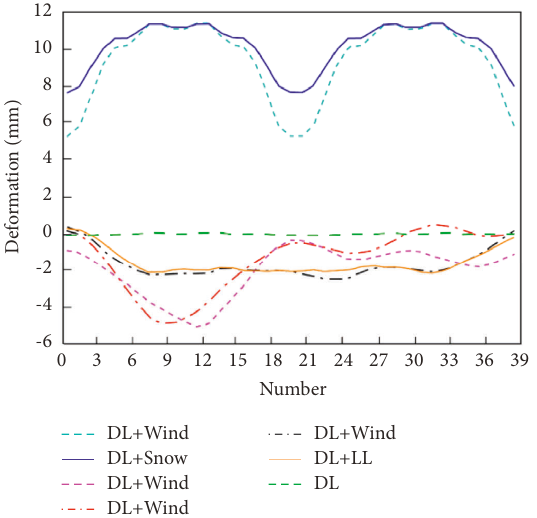
Figure 12: Circular connection element.